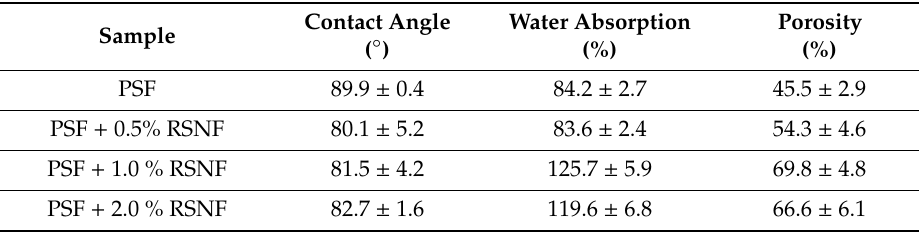
Table 4. Water contact angle of the di ff erent PSF / RSNF